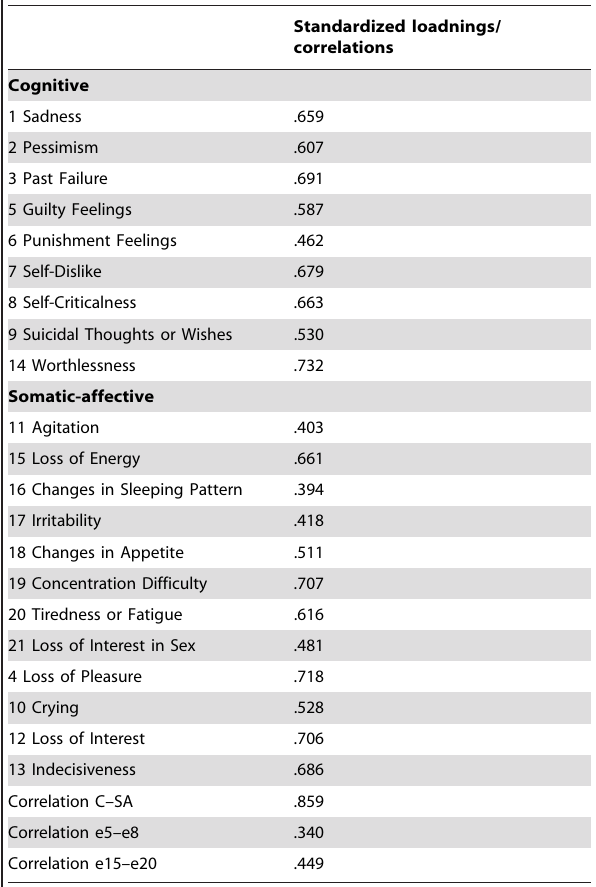
Table 4. Multigroup confirmatory factor analysis with robust maximum likelihood estimation. Standardized factor loadings, factor correlation and error correlations for the modified SA-C model [ 7 ]